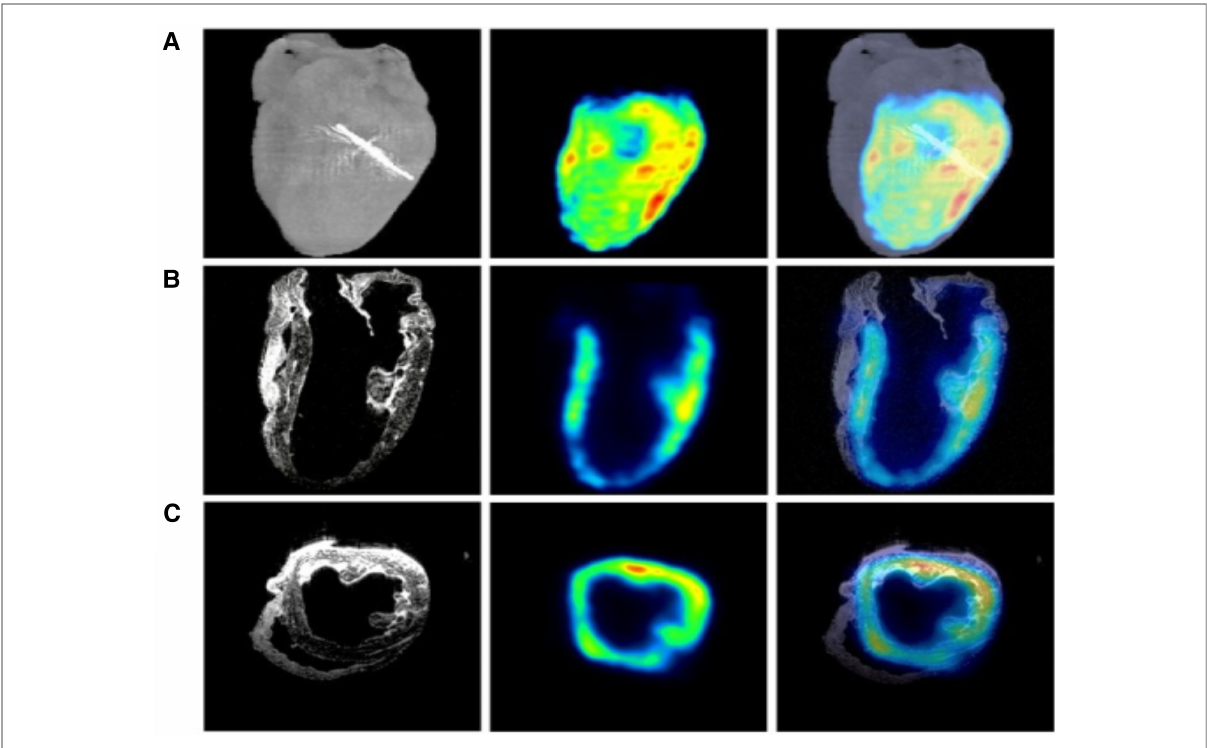
FIGURE 4 MRI, PET, and micro-CT are utilized to image a regionally ischemic heart. ( A ) Volumetric rendings with micro-CT and PET are merged acquisitions to indicate the site of left anterior descending coronary artery ligation. ( B ) Coronary slices from MRI and PET scans combined with the merger of another MRI and PET scan images are depicted. ( C ) Transverse slices from MRI, PET, and the merged images form an analogous perfused heart. Hypointense T2-weighted MRI signals from ferrum (iron) couple with PET signals